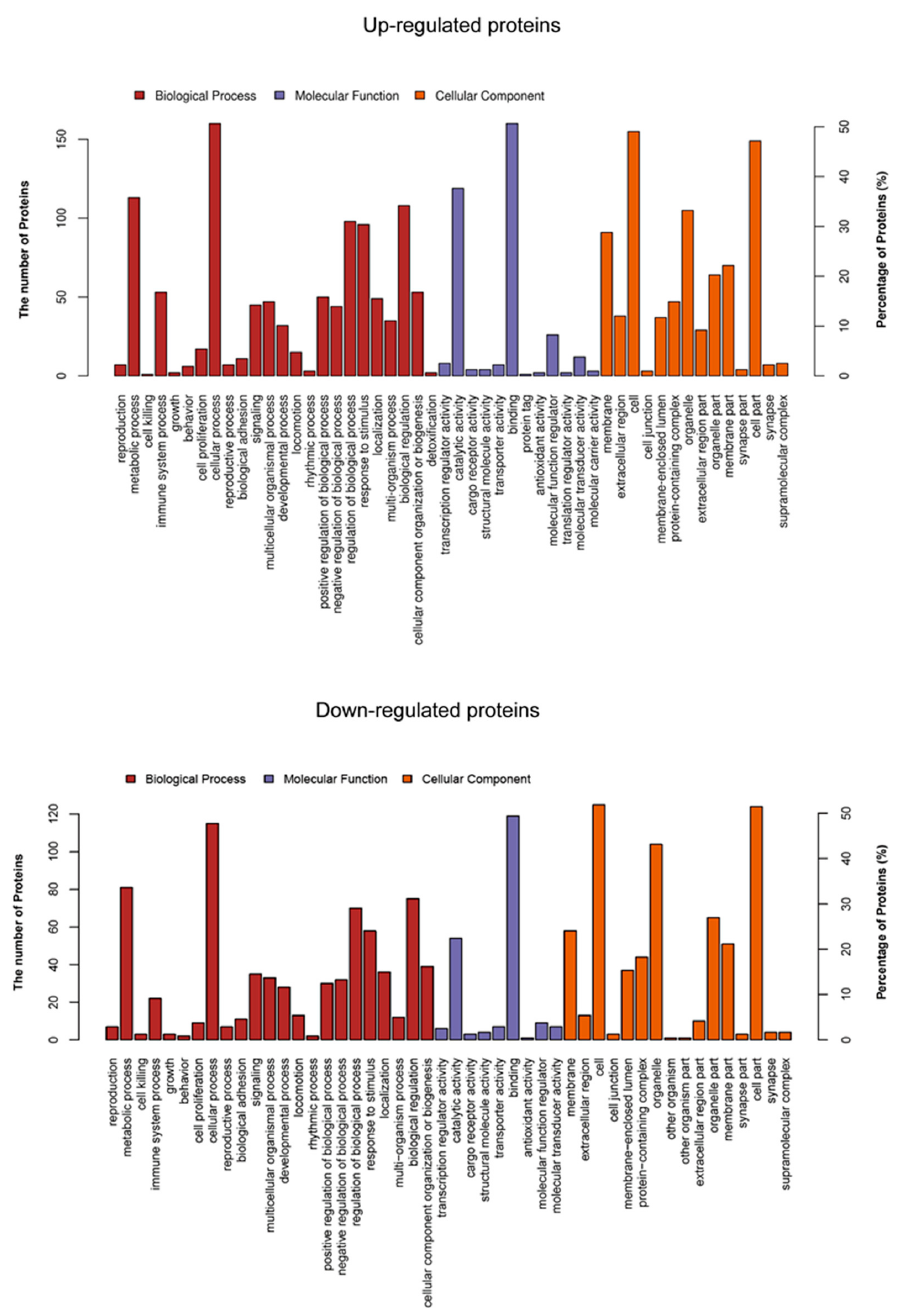
Figure 4. Functional cluster of up- and down-regulated proteins. Biological process, cellular component, and molecular function. Each graph bar indicates the number of the regulated proteins enriched.